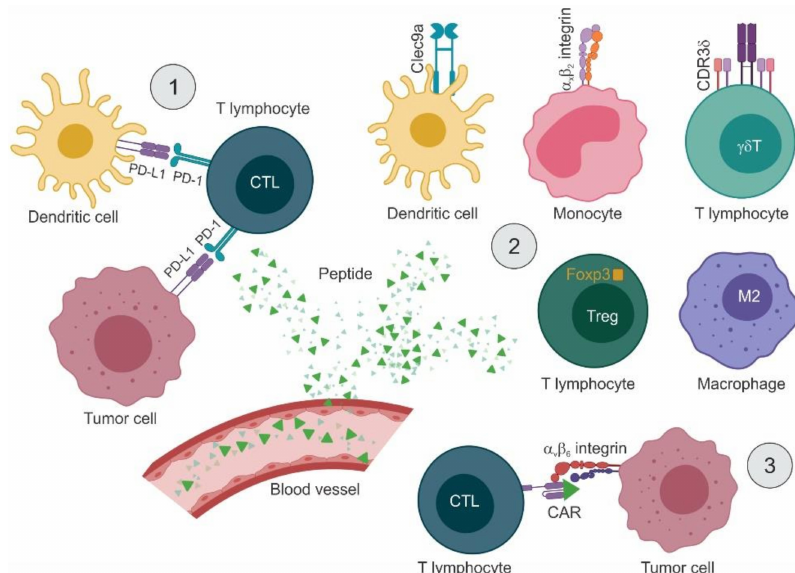
Figure 3. Phage display-derived peptides as nanomodulators of the immune response. Peptides administered intravenously can exit the blood vessels and reach di ff erent cell types to ( 1 ) inhibit PD-1 / PD-L1 interaction or ( 2 ) target immune cells for either activation (dendritic cells, monocytes, λδ T lymphocytes) or inhibition (Tregs, M2-like macrophages) of their functions. ( 3 ) Selected peptides can also be exploited in a CAR strategy. Abbreviations: PD-1, programmed cell death 1; PD-L1, programmed cell death ligand 1; CTL, cytotoxic T lymphocytes; CDR, complementary